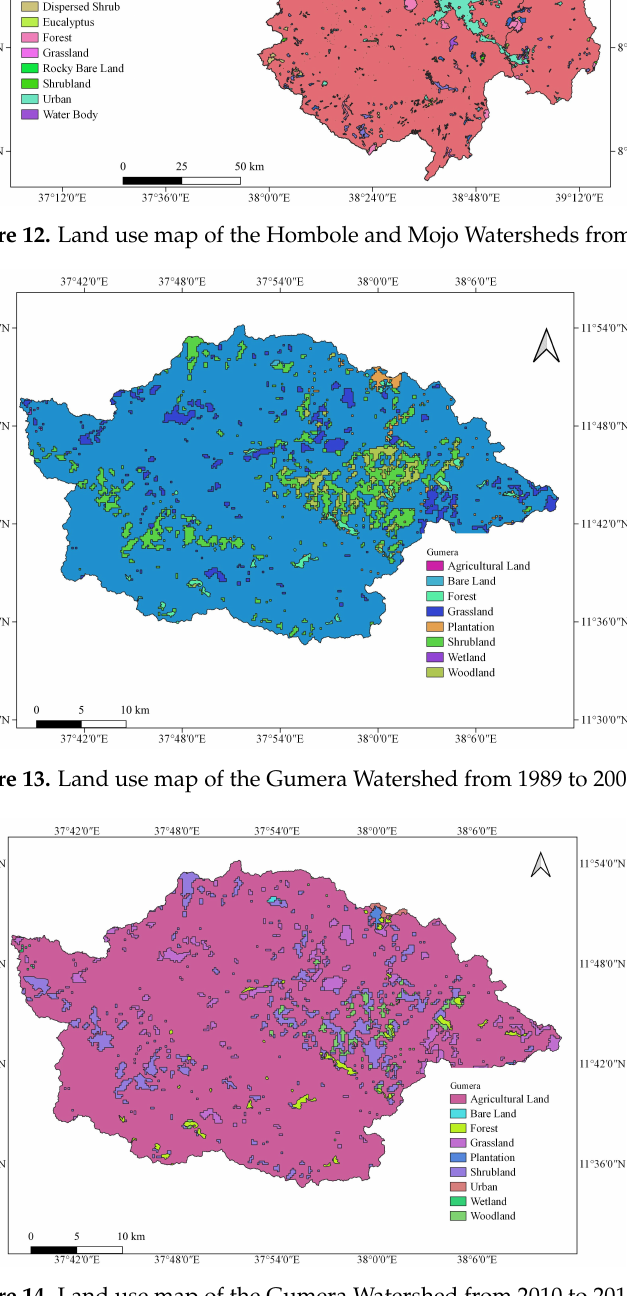
Figure 14. Land use map of the Gumera Watershed from 2010 to